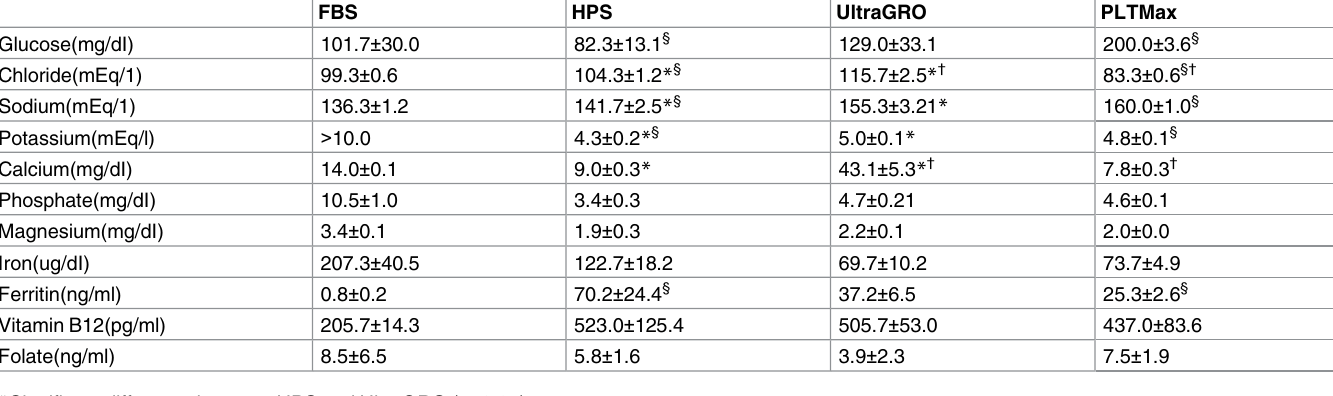
Table 2. Comparative chemical analysis of fetal bovine serum (FBS), human peripheral serum(HPS), and 2 commercialized human platelet lysates (UltraGRO, PLTMax) (n =